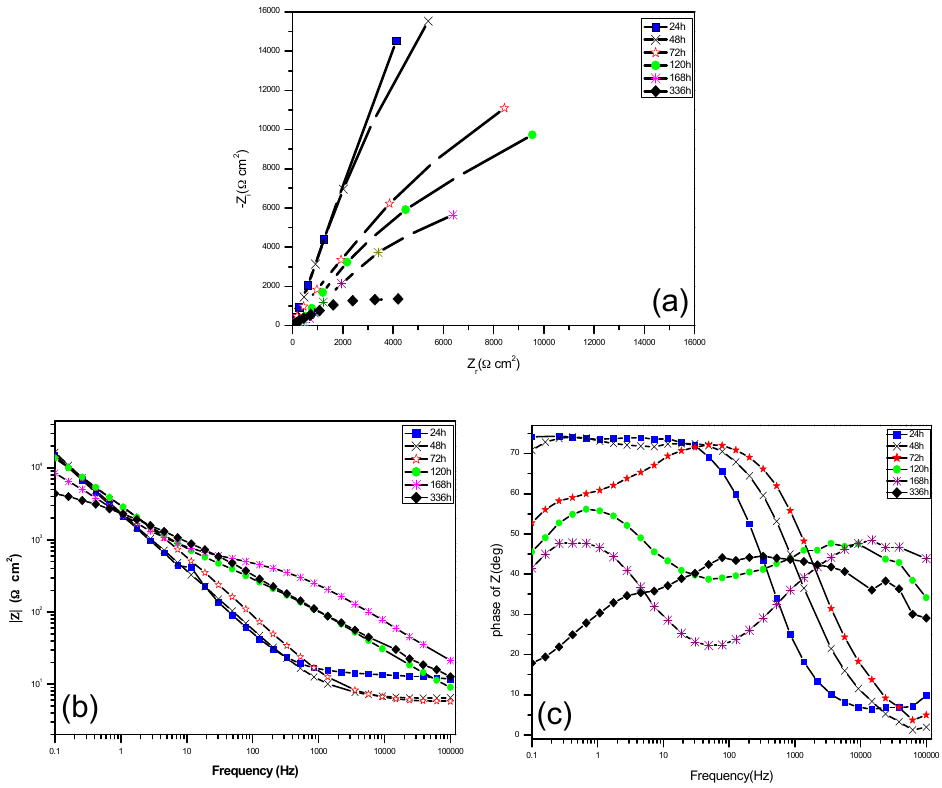
Figure 4. Electrochemical Impedance Spectroscopy (EIS) of titanium immersed for different time in enriched artificial saliva containing S. sanguis at 37 °C ( a ) Nyquist plots; ( b ) Bode modulus diagrams; and ( c ) Bode phase angle diagrams.